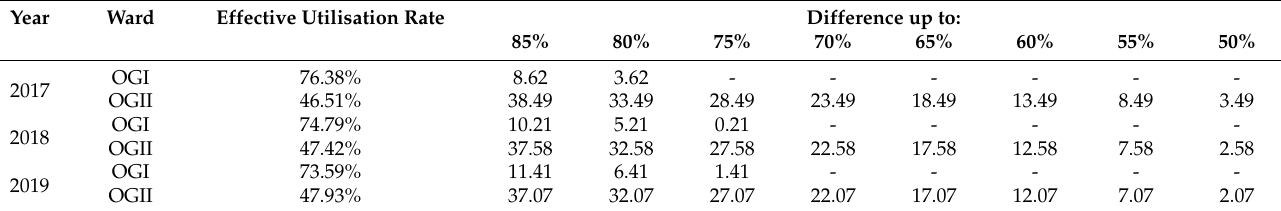
Table 2. Actual occupancy of wards and difference from planned occupancy.